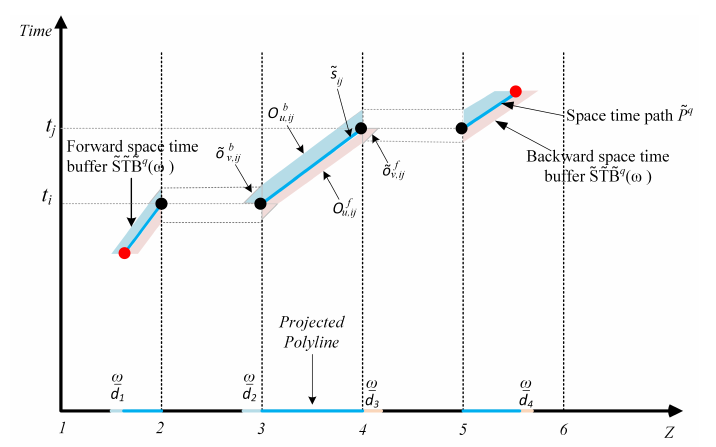
Figure 4. Network spacetime buffer in CLR space (Adapted from